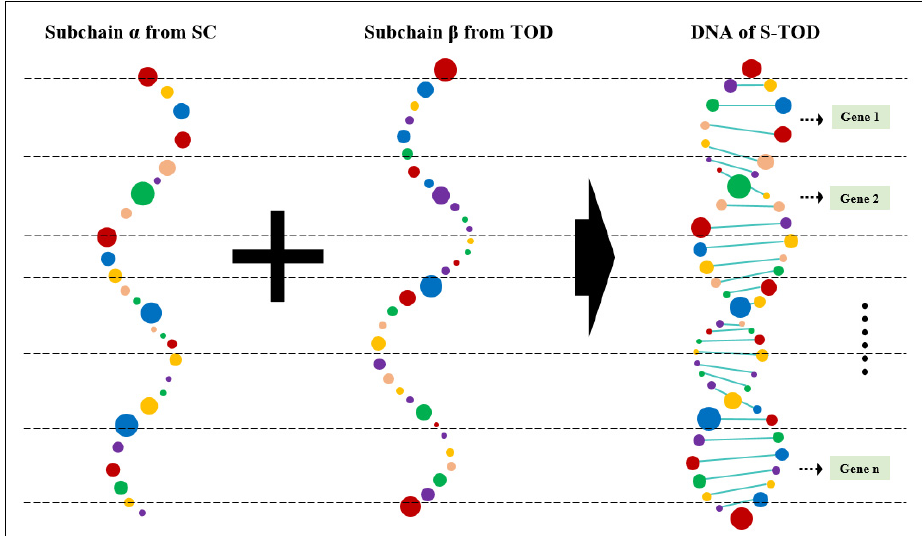
Figure 5. The DNA of S-TOD and its subchains.